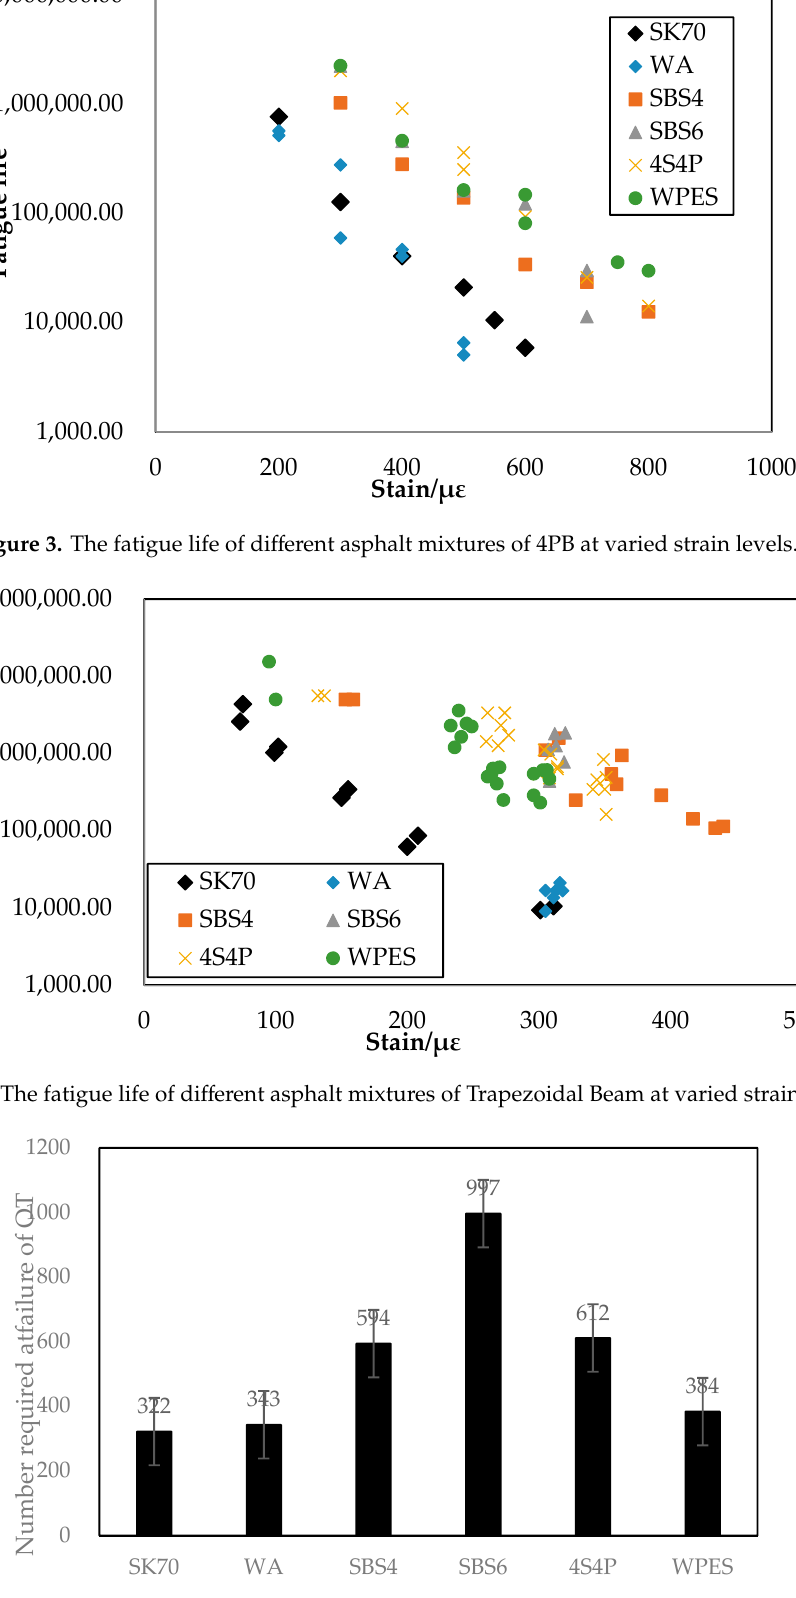
Figure 5. The fatigue life of di ff erent asphalt mixtures of Overlay Tester (OT) at a strain of 300 × 10 − 6 Figure 5. The fatigue life of different asphalt mixtures of Overlay Tester (OT) at a strain of 300 × 10 − 6 . Figure 5. The fatigue life of different asphalt mixtures of Overlay Tester (OT) at a strain of 300 × 10 − 6 . Figure 5. The fatigue life of different asphalt mixtures of Overlay Tester (OT) at a strain of 300 × 10 − 6 .